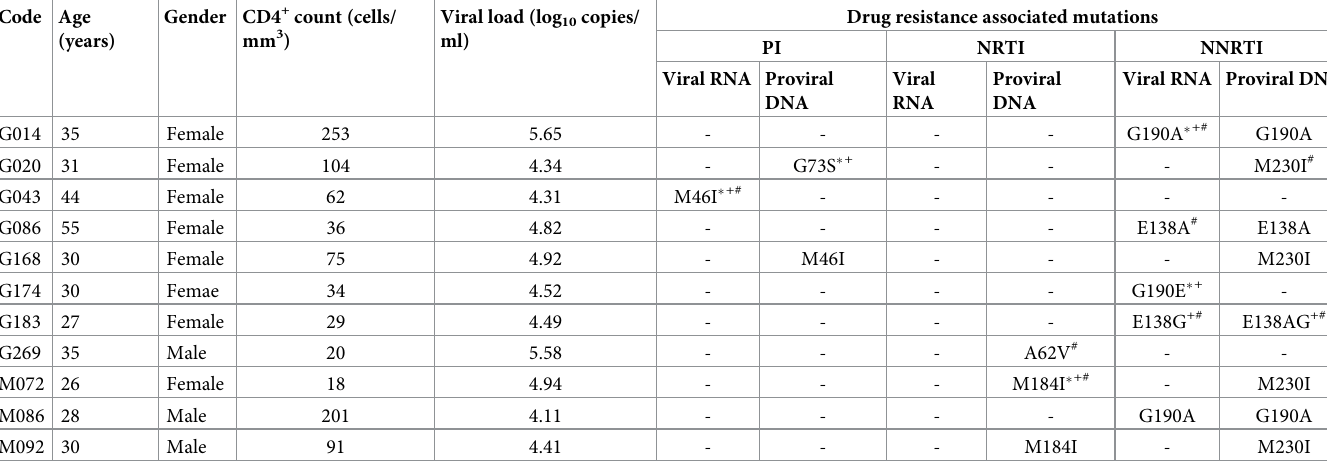
Table 2. Characteristics of patients with transmitted drug resistant strains.